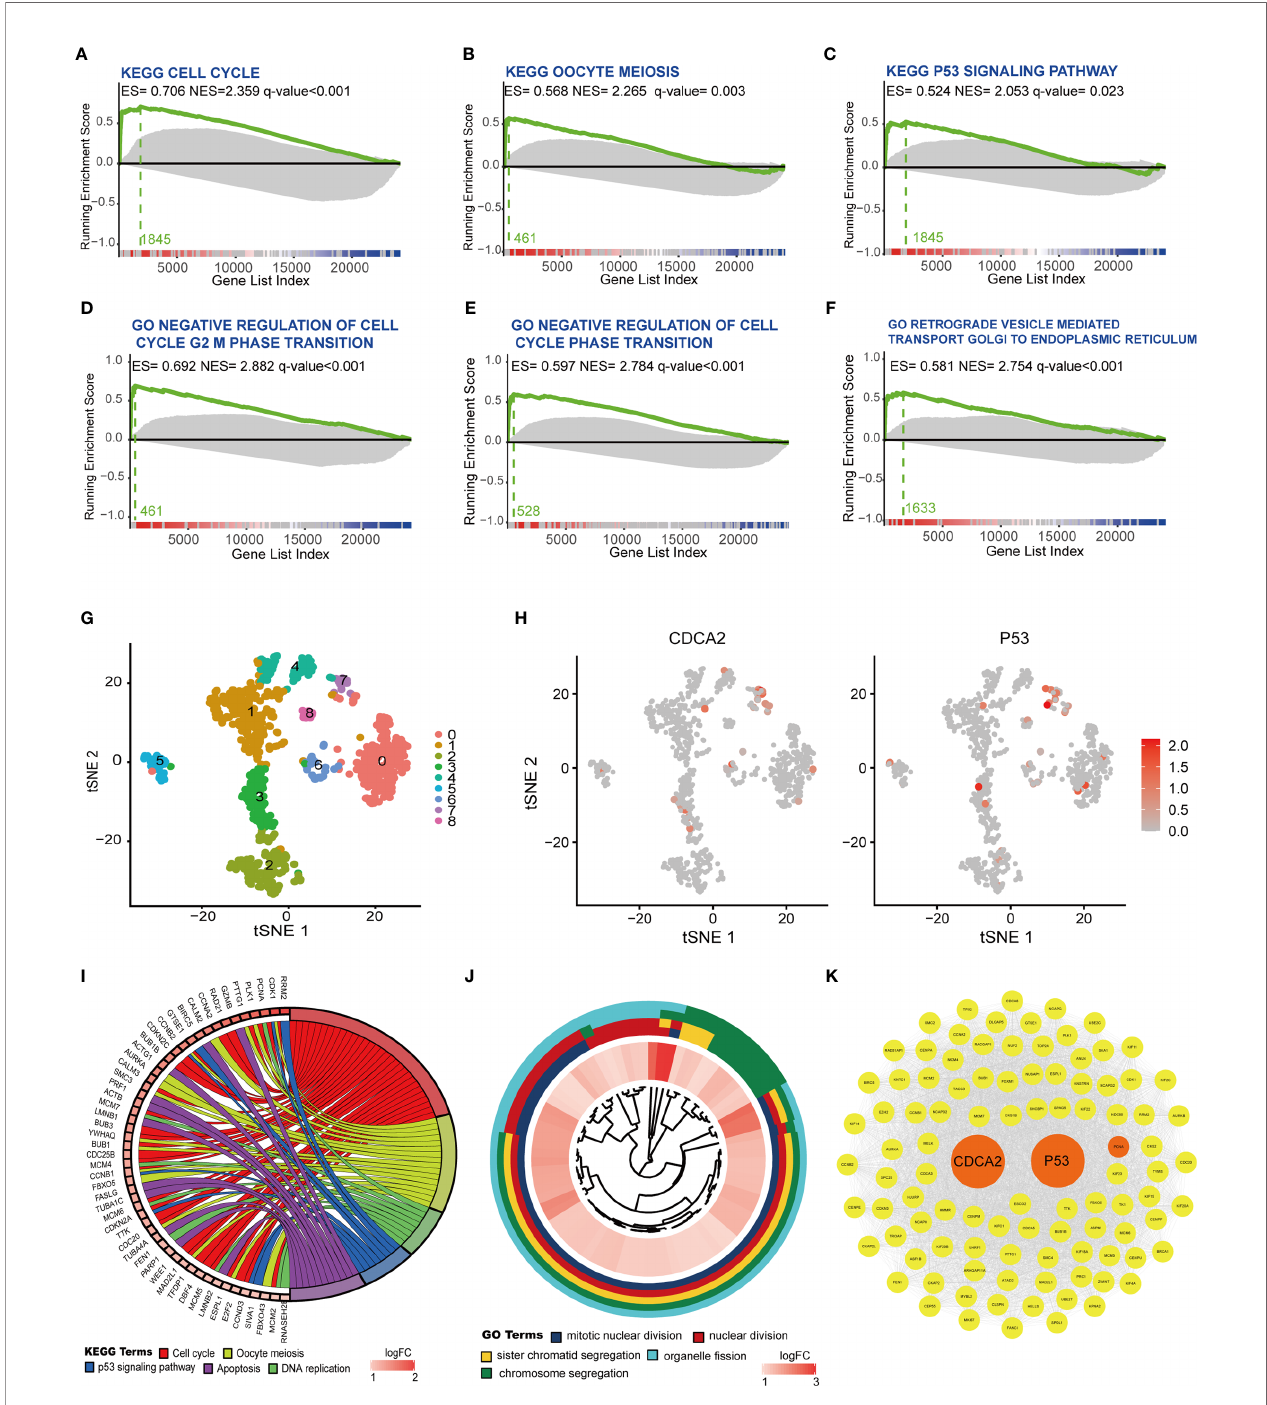
FIGURE 7 | Cell division cycle associated 2 (CDCA2) was associated with the p53 signaling and the expression of P53. (A – F) Analysis of CDCA2 correlation with Kyoto Encyclopedia of Genes and Genomes (KEGG) and Gene Ontology (GO) gene sets was performed by the R software with gene set enrichment analysis (GSEA) package in The Cancer Genome Atlas (TCGA) database. Enrichment score (ES), normalized enrichment score (NES), and q values were shown in each vignette with the Zero cross at 13357. (G) Hepatocellular carcinoma (HCC) cells were delineated into nine clusters, from 0 to 8, shown in different colors with the R software with Seurat package, respectively. (H) Application of red to highlight the distribution of CDCA2 and p53 expression in different clusters in the tSNE map. (I, J) KEGG pathway and GO enrichment analysis of marker genes in cluster 7. (K) Protein – protein interaction (PPI) relationship of core genes associated with CDCA2 and